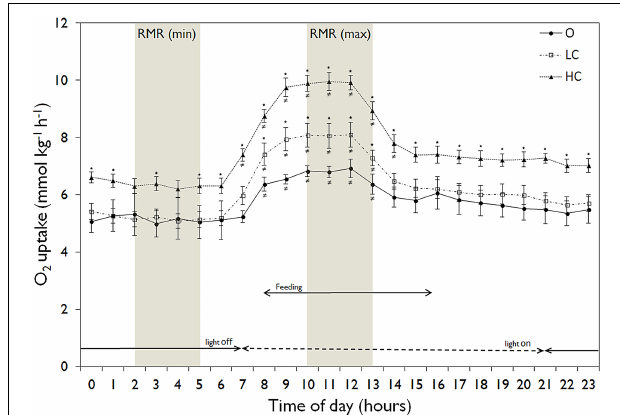
FIGURE 2 | Daily patterns of mean ( ± SE) hourly routine metabolic rate (RMR, normalized to 300 g) in the three experimental groups. High current, HC = 1 BL s − 1 ; low current, LC = 0.5 BL s − 1 ; and O = no current ( n = 4 in HC and LC; n = 3 in O). Light conditions and feeding hours indicated by arrows. The shaded areas show the time points corresponding to the minimum and maximum values for RMR. An asterisk denotes significant difference from corresponding value for the O group, while a not-equal to sign denotes a significant difference from minimum RMR